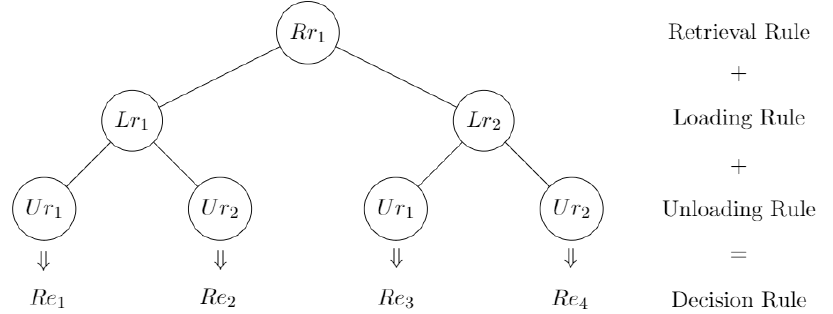
Figure 8. Rules produced by combining retrieval, loading, and unloading